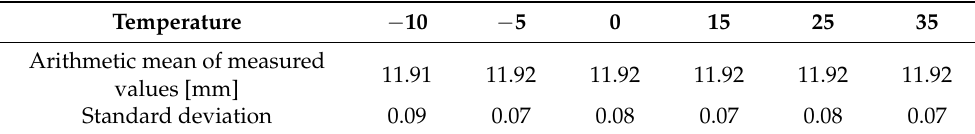
Figure 10. Block diagram of magnetic field strength measurement. Table 6. Measured values of magnetic field